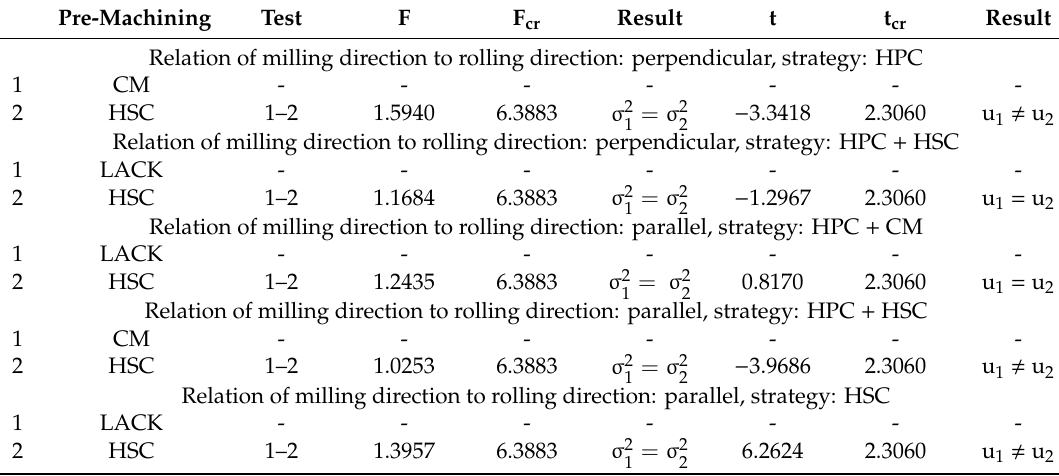
Table 9. Statistical verification of the results of relative deformations ε ( α = 0.05)—comparison of pre-machining